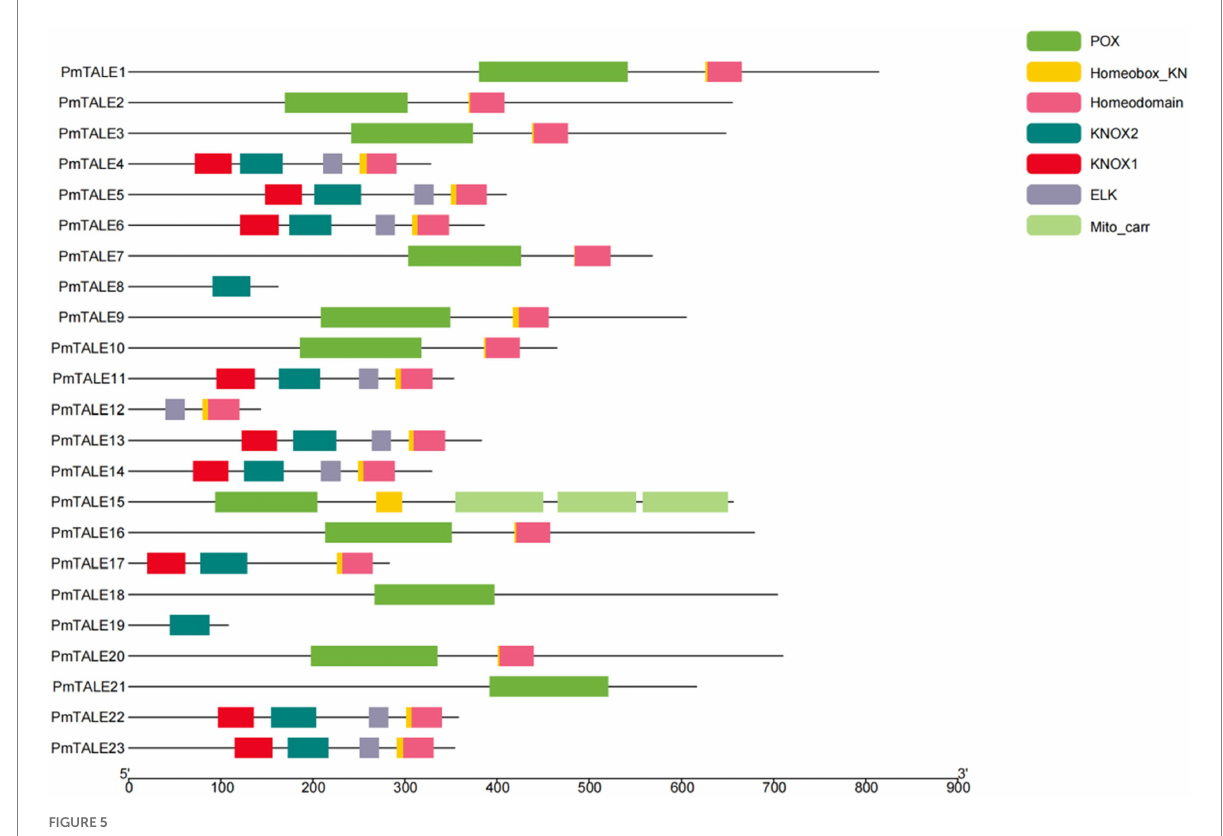
FIGURE 5 Analysis of the protein sequence domain of the Prunus mume TALE gene family.